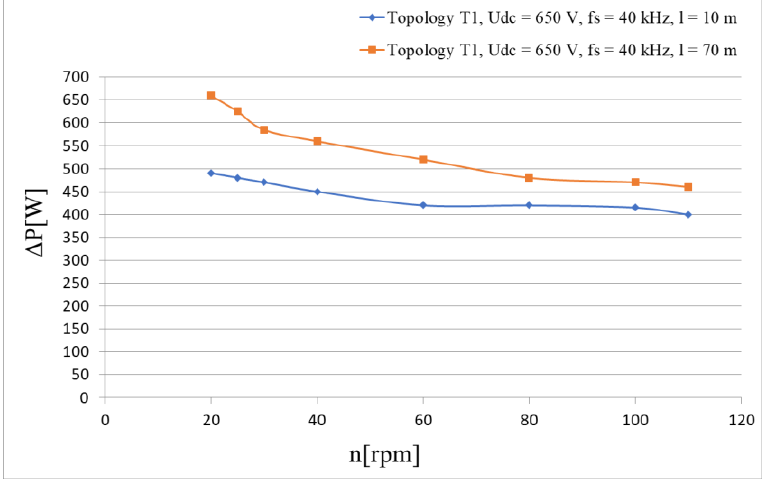
Figure 14. Power losses in converters of the topology T1 depending on the length of the cable connecting the generator to the converter.